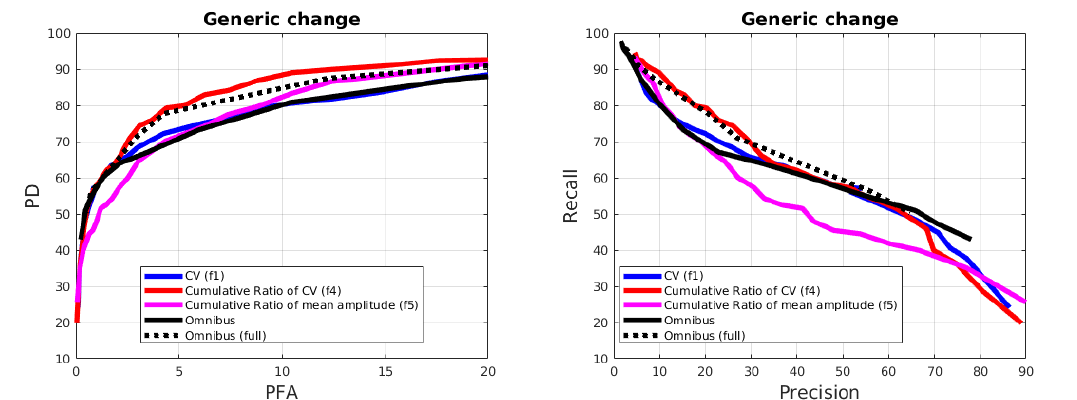
Figure 8. Generic Change Detection (Saclay site, France), PD/PFA on the left, Precision/Recall on the right.